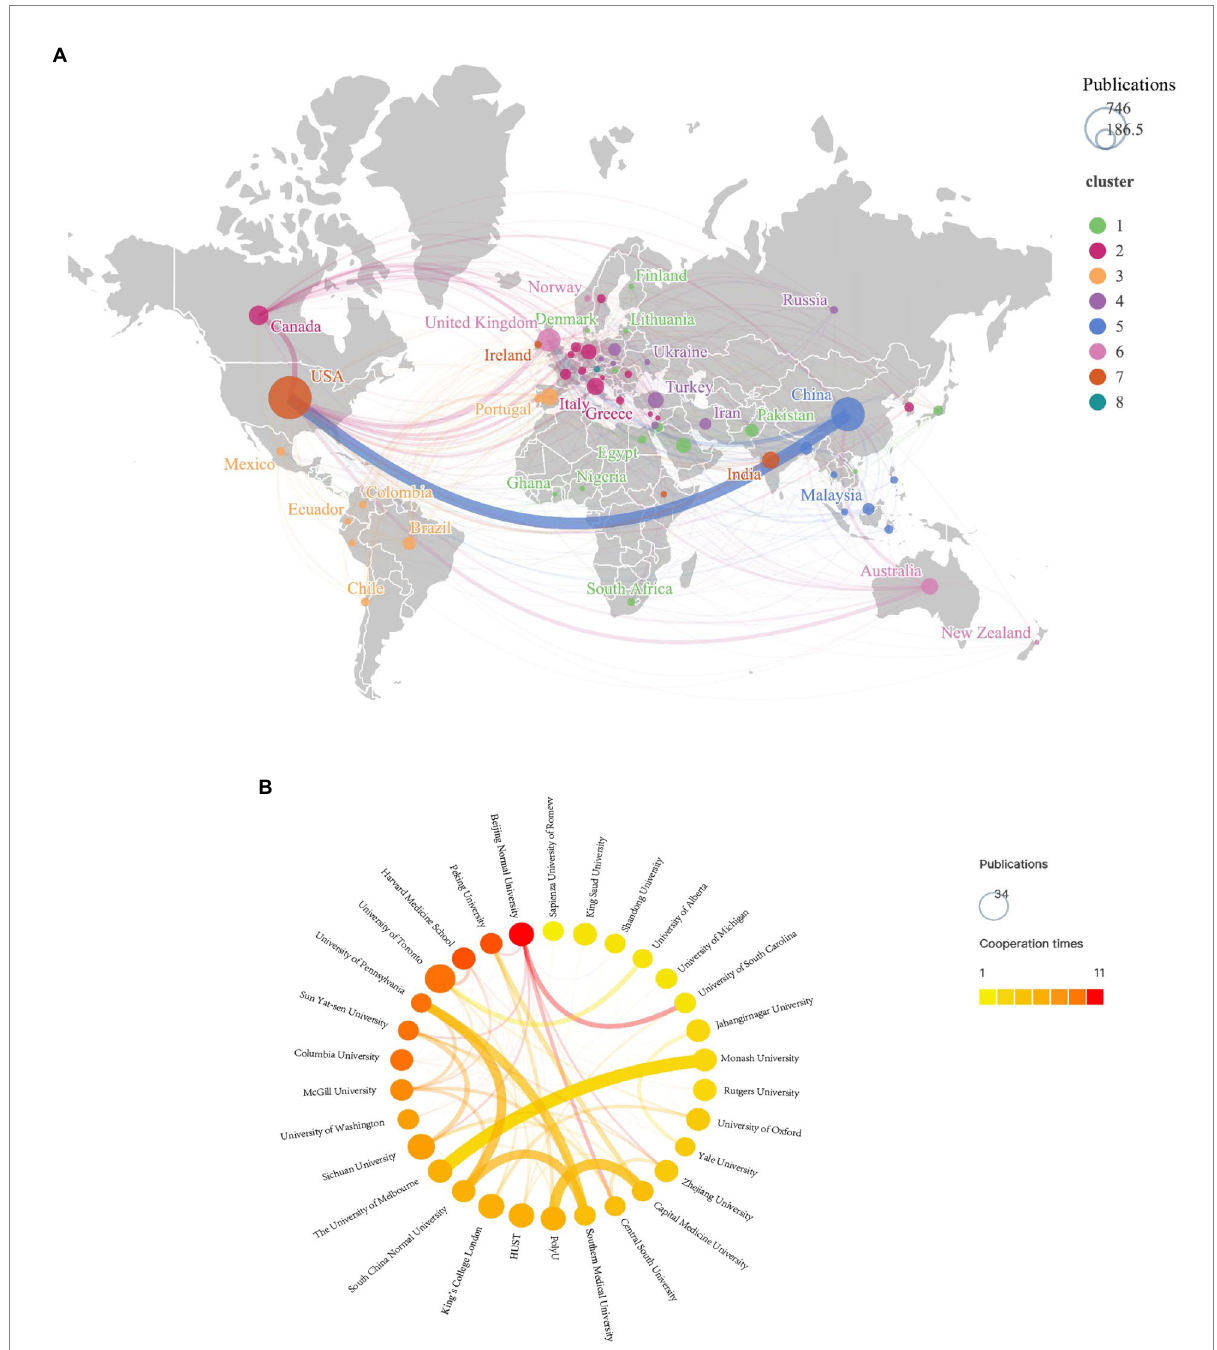
FIGURE 2 Collaboration visualization between countries/regions or institutions. (A) Collaboration analysis of countries/regions. (B) Collaboration analysis of